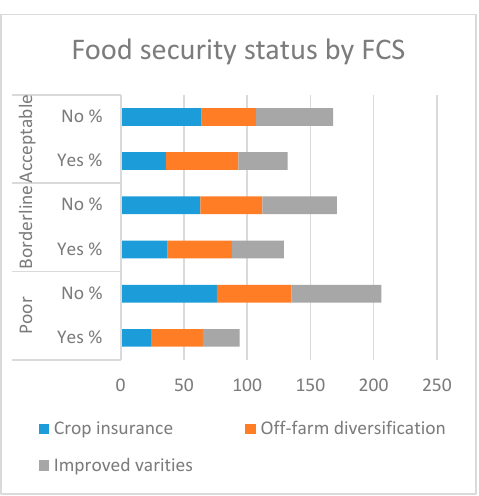
Figure 7. Food consumption status.